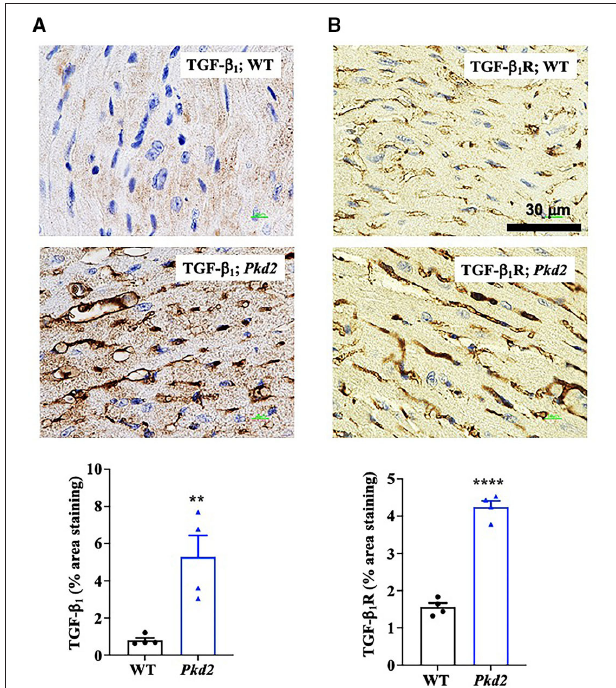
FIGURE 8 | The hearts from Pkd2 -KO mice are characterized with upregulated fibrotic pathways. (A,B) Immunohistochemistry staining demonstrated a significant increase of TGF- β 1 and TGF- β 1 receptor (dark brown color) in Pkd2 -KO ( Pkd2 ) hearts compared to the wild-type (WT). A total of 8 independent slides were used for each mouse. ** p < 0.01; **** p <